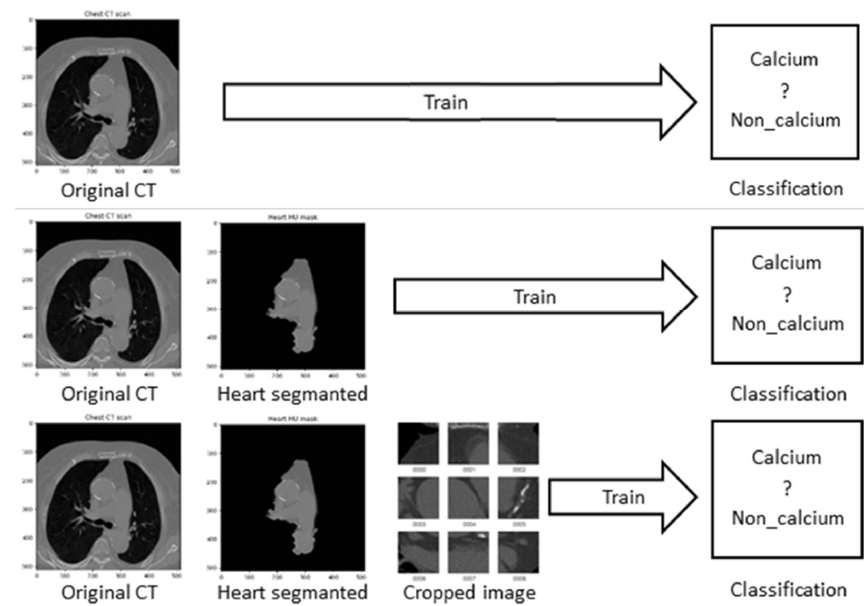
Figure 9. Flowchart of training process for each CT dataset.